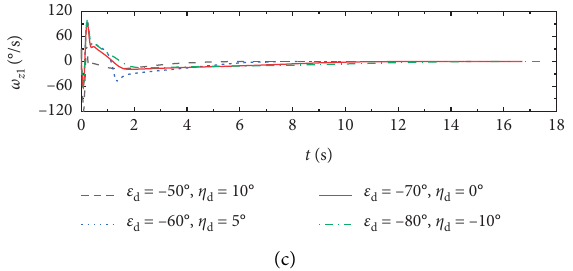
Figure 5: Curves representing pitch, yaw, and roll angular rates of Case 1.